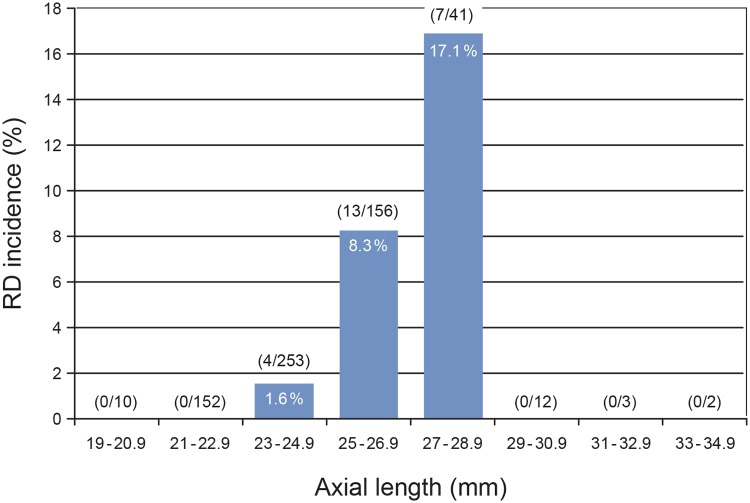
The incidence of RD after cataract surgery or RLE as a function of axial length.The number of RD cases and the number of non-RD eyes per each group of axial length are given in brackets.